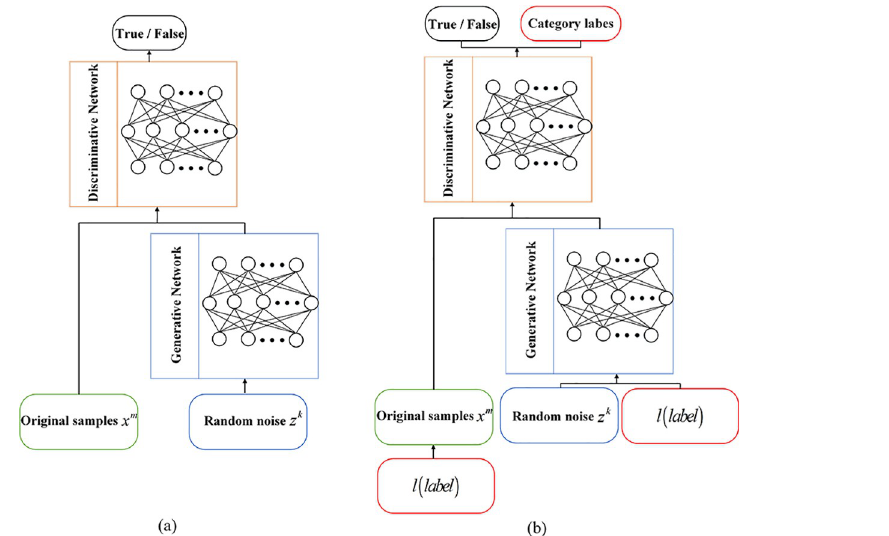
Fig 3. The structure of (a) reguar GAN, and (b)